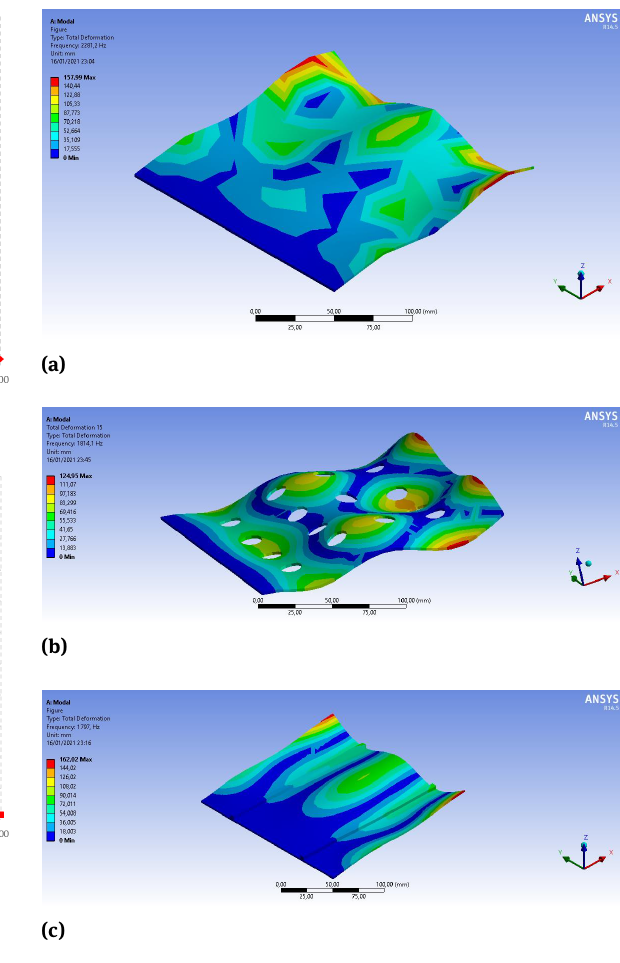
Figure 6: Total deformation contour of marine materials: ( a ) virgin metal sheet; ( b ) hole metal sheet; ( c ) stiffener metal